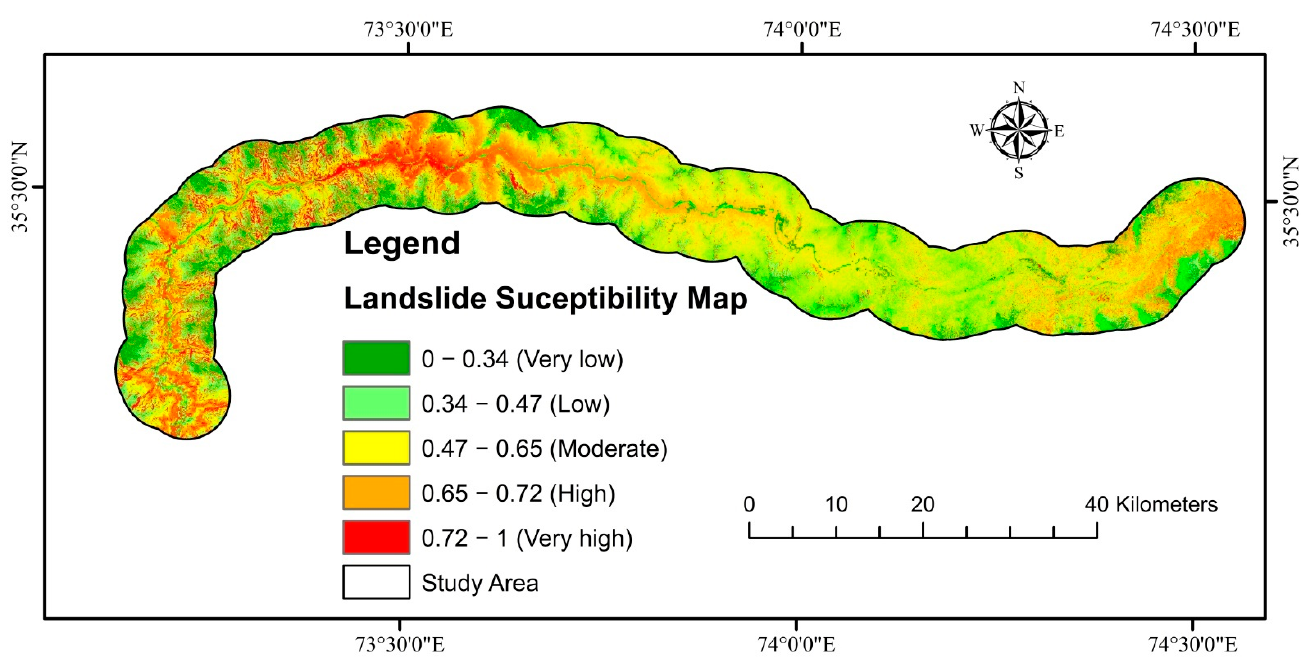
Figure 15. Final LSM via Vslope.